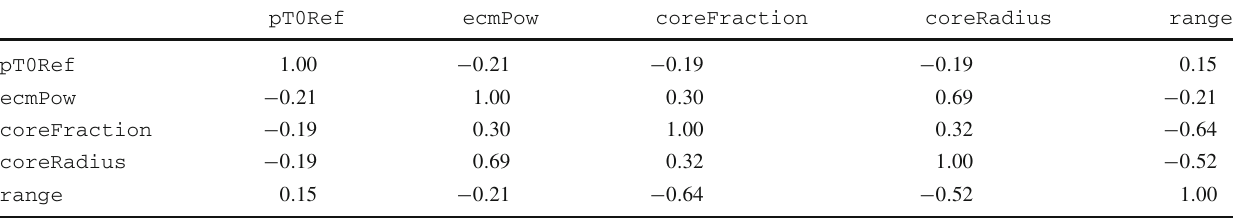
Table 8 The correlation matrix, retrieved when extracting the CP5 tune. This is obtained by evaluating the correlation values of the parameter variations obtained in the eigentunes